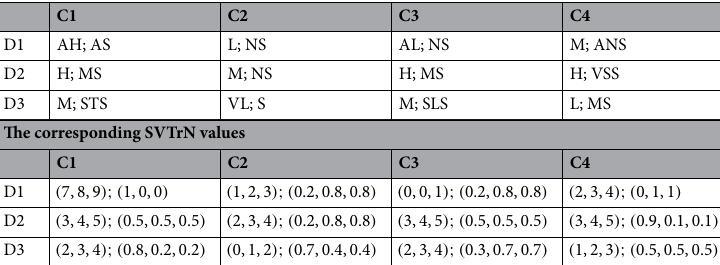
Table 3. The neutrosophic values for evaluating criteria regarding decision-makers.